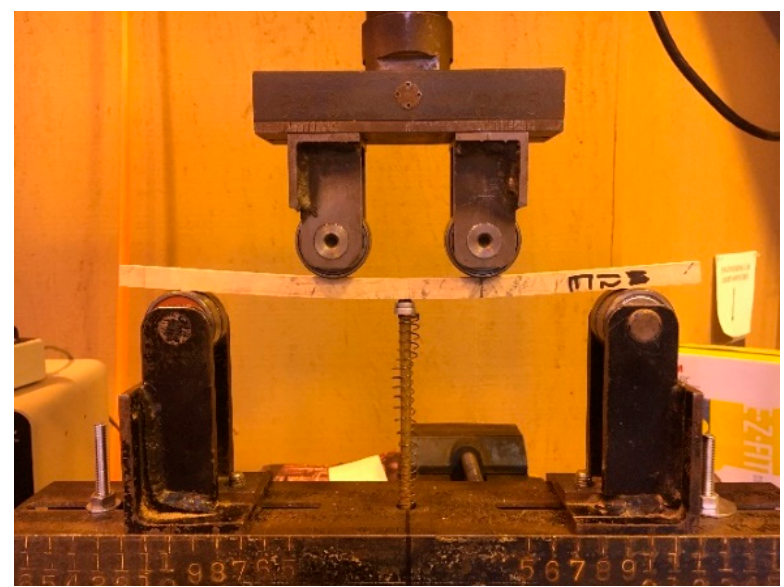
Figure 10. Third point bending setup in the edge wise direction showing load points and LVDT measuring deflection at centerline.